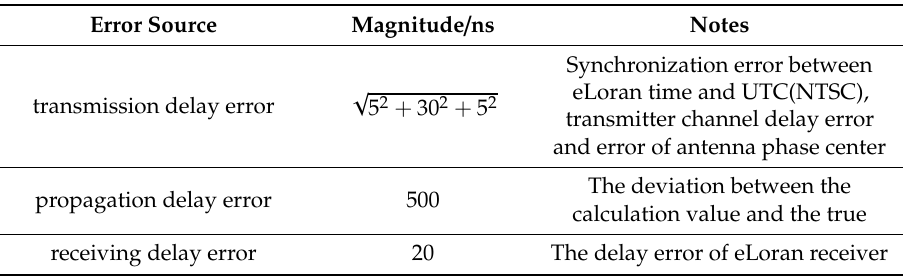
Table 1. Source of errors in eLoran